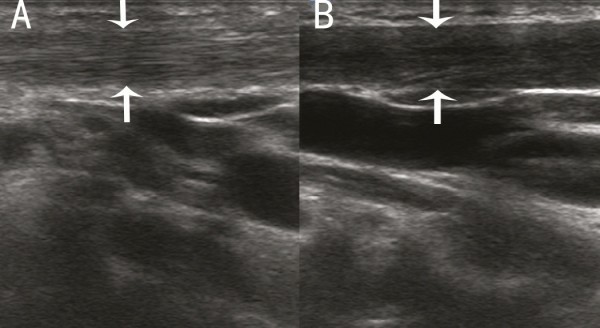
A. Vertical section of the sternocleidomastoid muscle (SCM) in a patient with late-stage muscular torticollis. B. Vertical section of the SCM of the normal side. The affected sternocleidomastoid muscle is thinned, and diffuse hyperechoic signals are apparent.